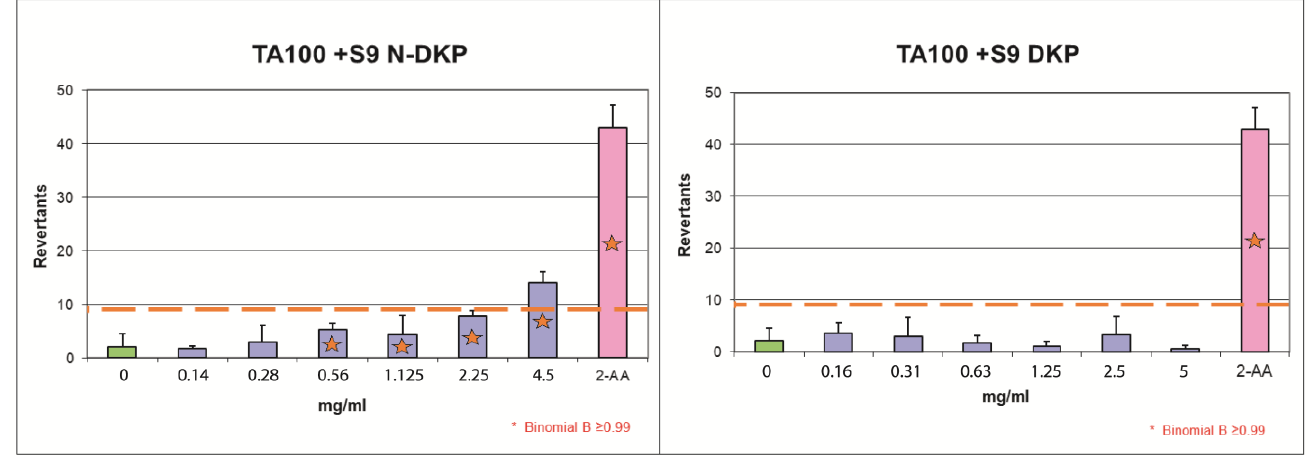
Figure 6. The results of bacterial reverse mutation test with TA100 strain with metabolic activation for the nitrosation mixture of DKP (N-DKP) and pure DKP.